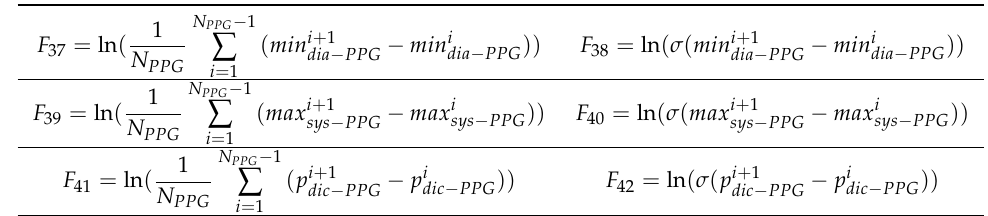
Table 3. Features from F 37 – F 42